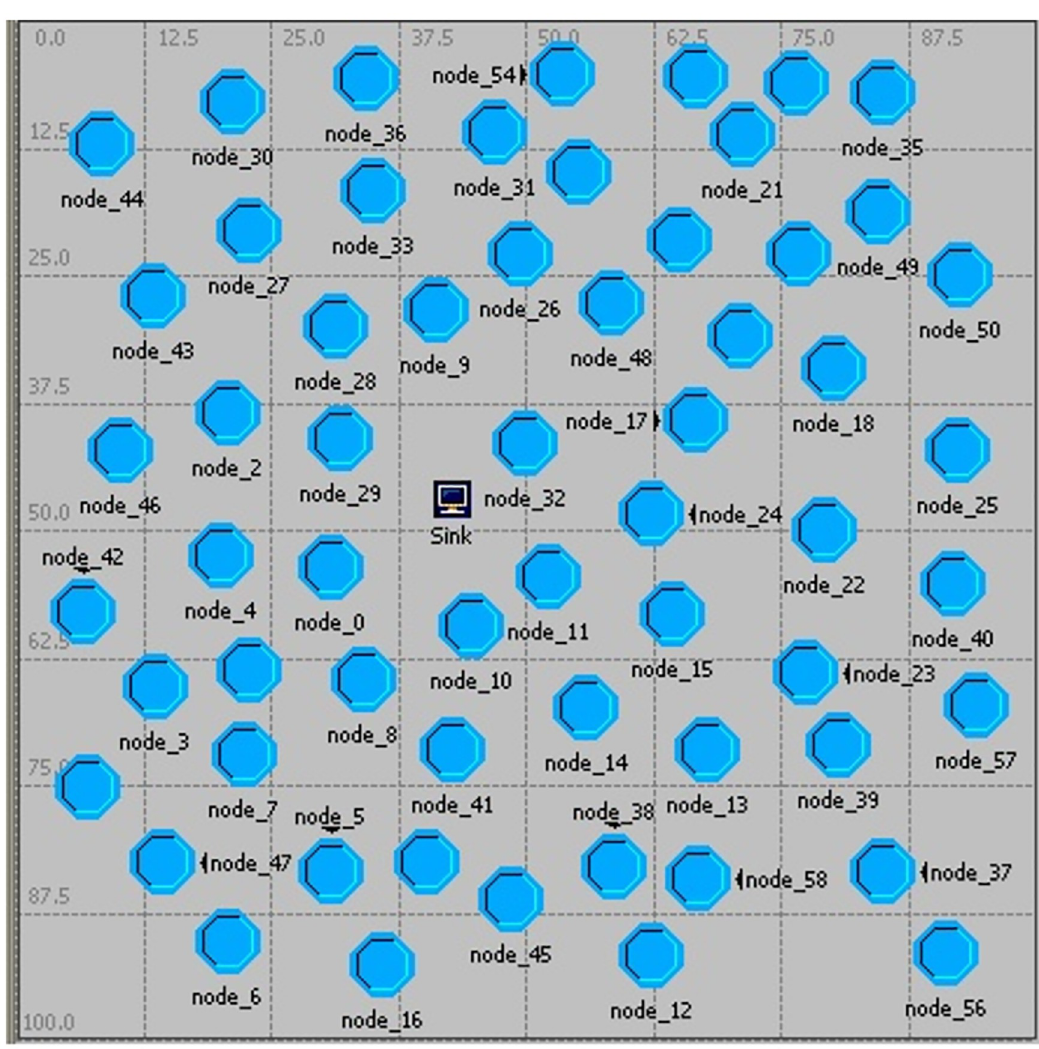
Fig 5. View of the simulated model network